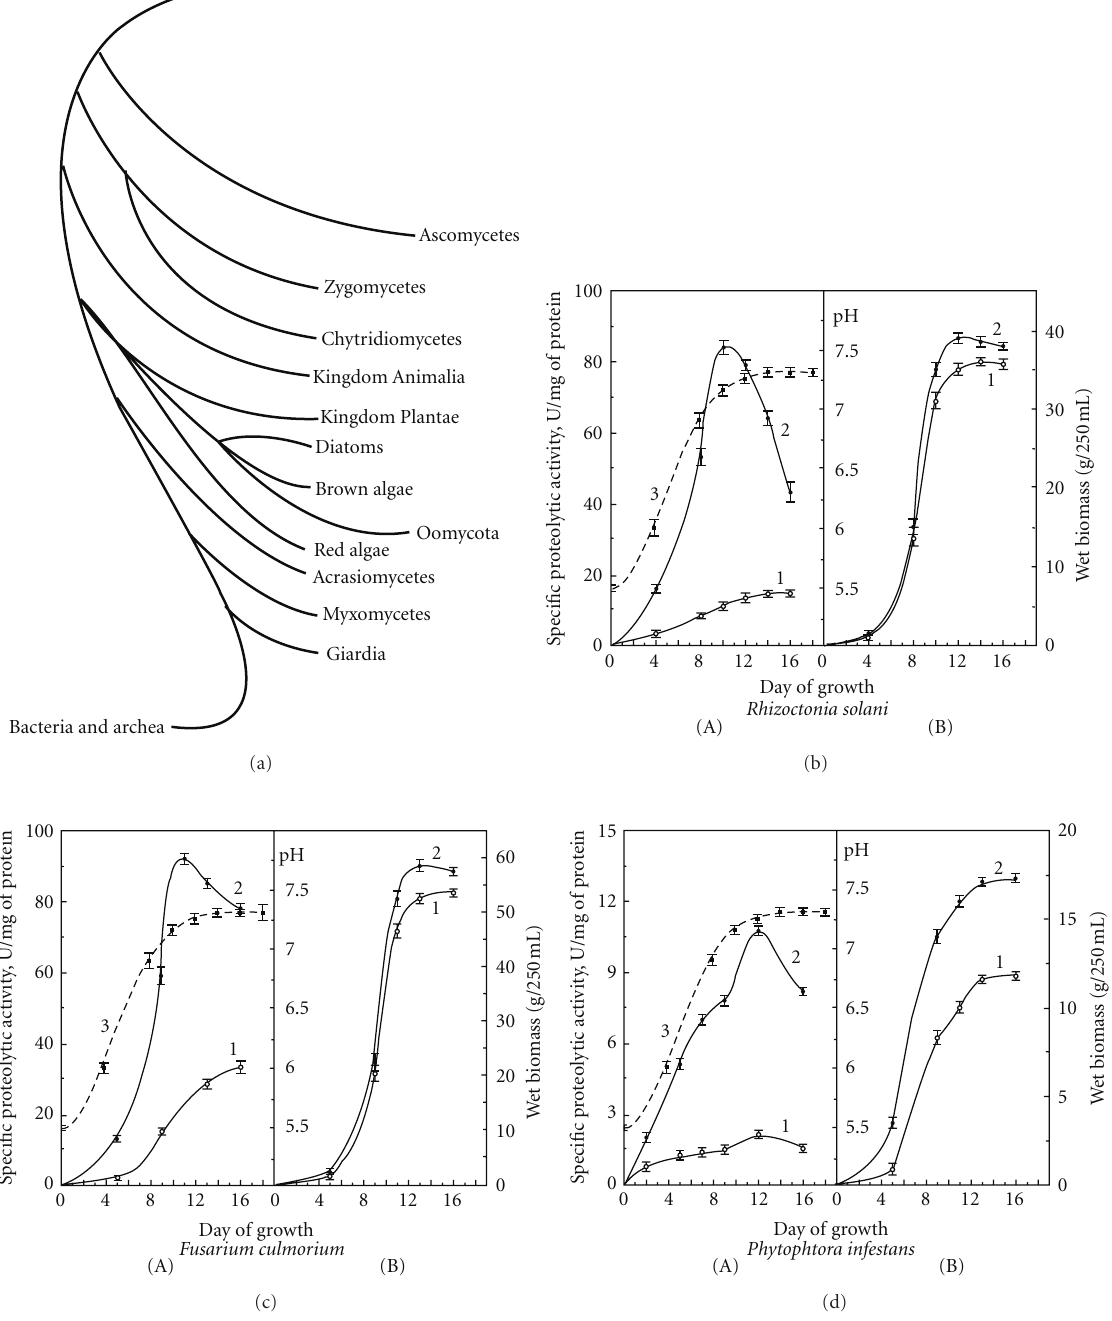
Figure 1: The fungal phylogenetic tree [4] (a) with mapping on it of the exoproteinase activity (A) and wet biomass (B) variations during the growth of R. solani (b), F. culmorum (c), and P. infestans (d) on culture media without (1) and with (2) yeast extract. Curve 3 shows the change in medium pH during the growth of the